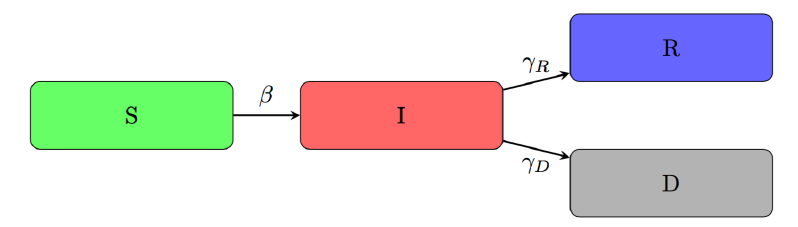
Figure 2. SIRD model compartments and